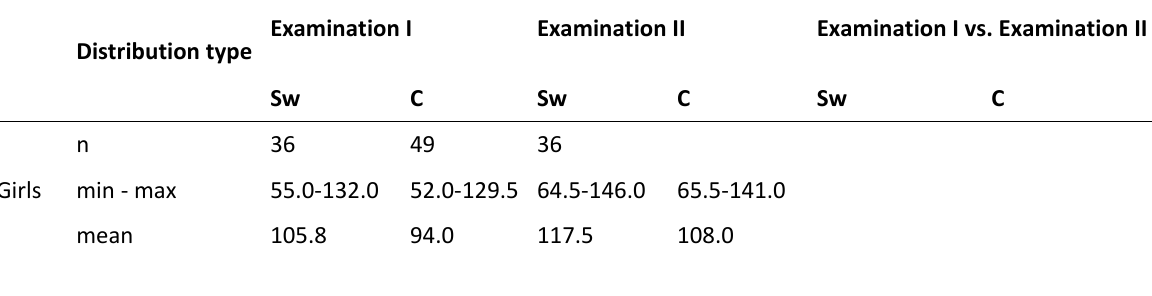
Table 5. Descriptive characteristics of Standing Broad Jump Test (explosive leg power) results in the Swimmers (Sw) group and Control (C)